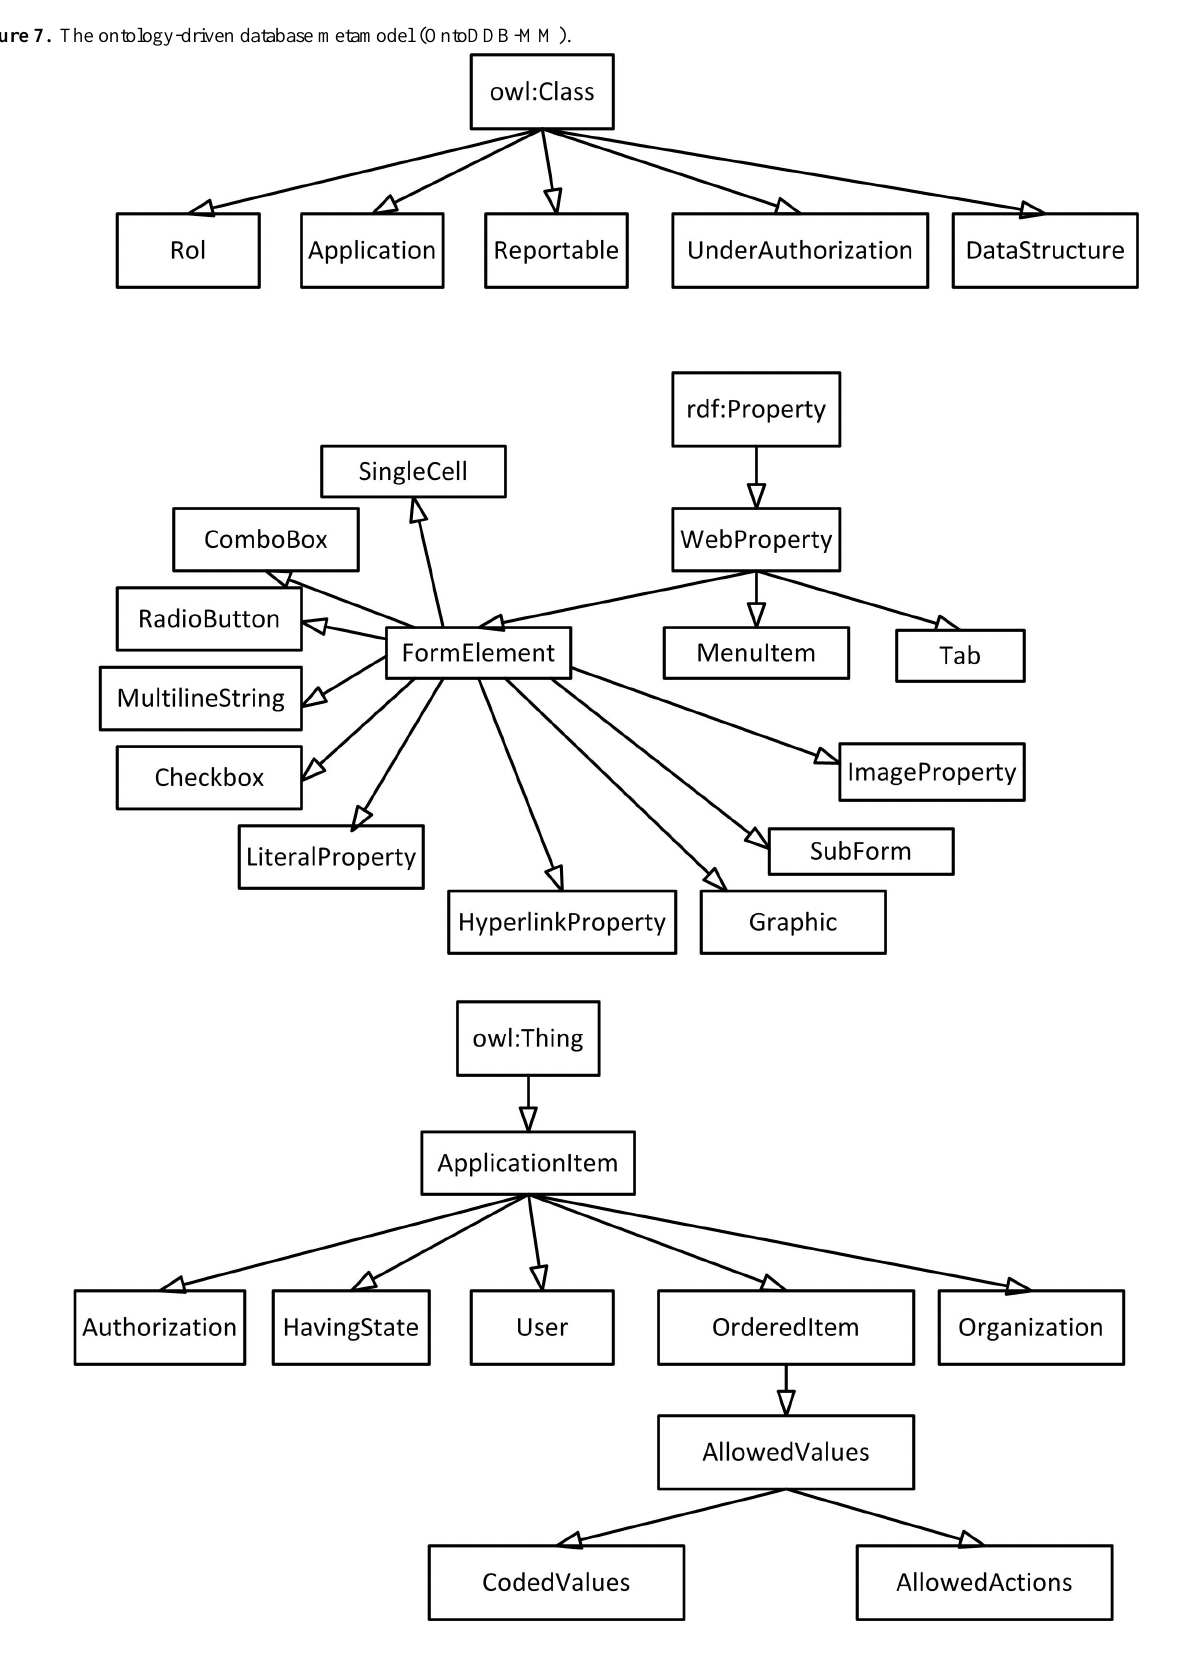
Figure 7. The ontology-driven database metamodel